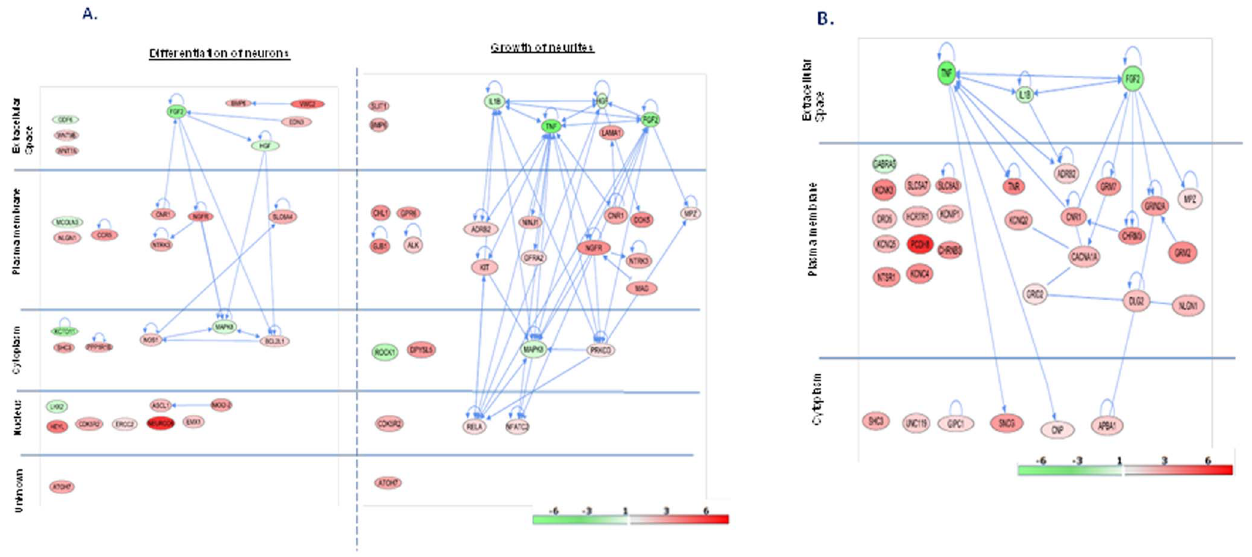
Figure 3. Regulatory networks showing the clusters of differentially-regulated genes involved in ‘‘nervous development and functions’’. The nodes represent the genes and the solid lines depict the interactions between two molecules. Red- and green-colored genes show significantly increased and decreased expression (log 1.5 (FD-/SD-fed mice) in the FD-fed mice compared to the SD-fed mice (a color scale is at the bottom right corner). The genes are clustered based on their proteins’ cellular locations in the nucleus, cytoplasm, plasma membrane, and extracellular space. The genes without the location information are grouped under ‘unknown’. Figure 3A depicts the two top-ranked subcategories of ‘‘neurogenesis’’. ‘‘Differentiation of neurons’’ (left panel) and ‘‘growth of neurites’’ (right panel) enlist 30 and 29 genes with p values of 1.7 6 10 2 31 and 2.3 6 10 2 24 , respectively. Figure 3B depicts ‘‘synaptic transmission’’, the most significant nervous function. It enlists 34 genes, p =4.9 6 10 2 7 .